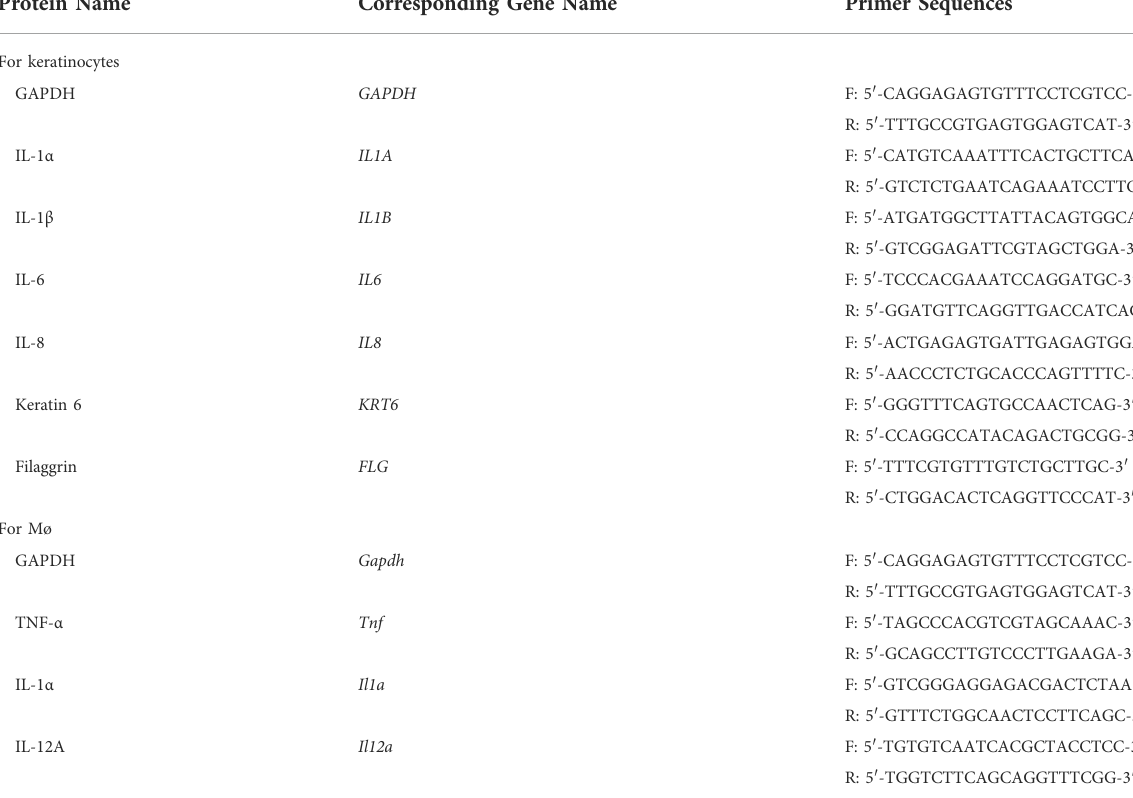
TABLE 1 Primers used in